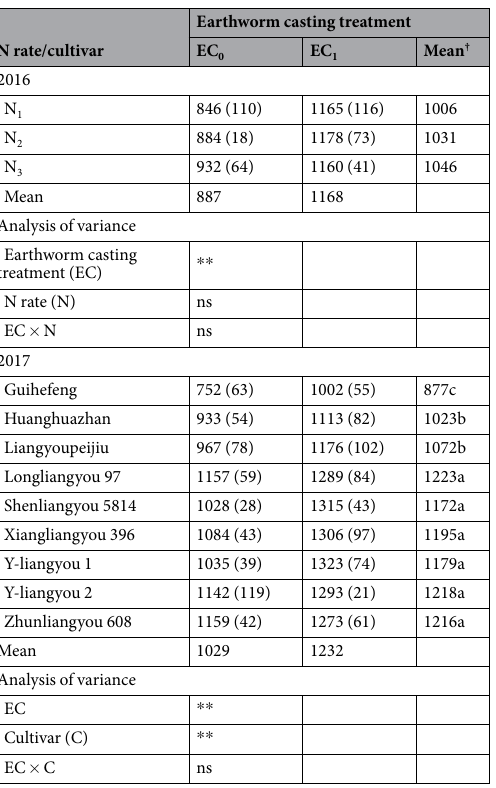
Table 1. Grain yields (g m − 2 ) from a rice cultivar Liangyoupeijiu grown under absence (EC 0 : 0 kg m − 2 ) and presence of earthworm castings (EC 1 : 17 kg m − 2 ) with three N rates (N 1 : 9 g m − 2 ; N 2 : 12 g m − 2 ; and N 3 : 15 g m − 2 ) in 2016, and from nine rice cultivars grown under EC 0 and EC 1 with one N rate (N 2 ) in 2017. Values in parenthesis are the standard deviations. † Means of cultivars with the same letters are not significantly different at the 0.05 probability level (LSD test). ** represents significance at the 0.01 probability level. ns denotes non- significance at the 0.05 probability